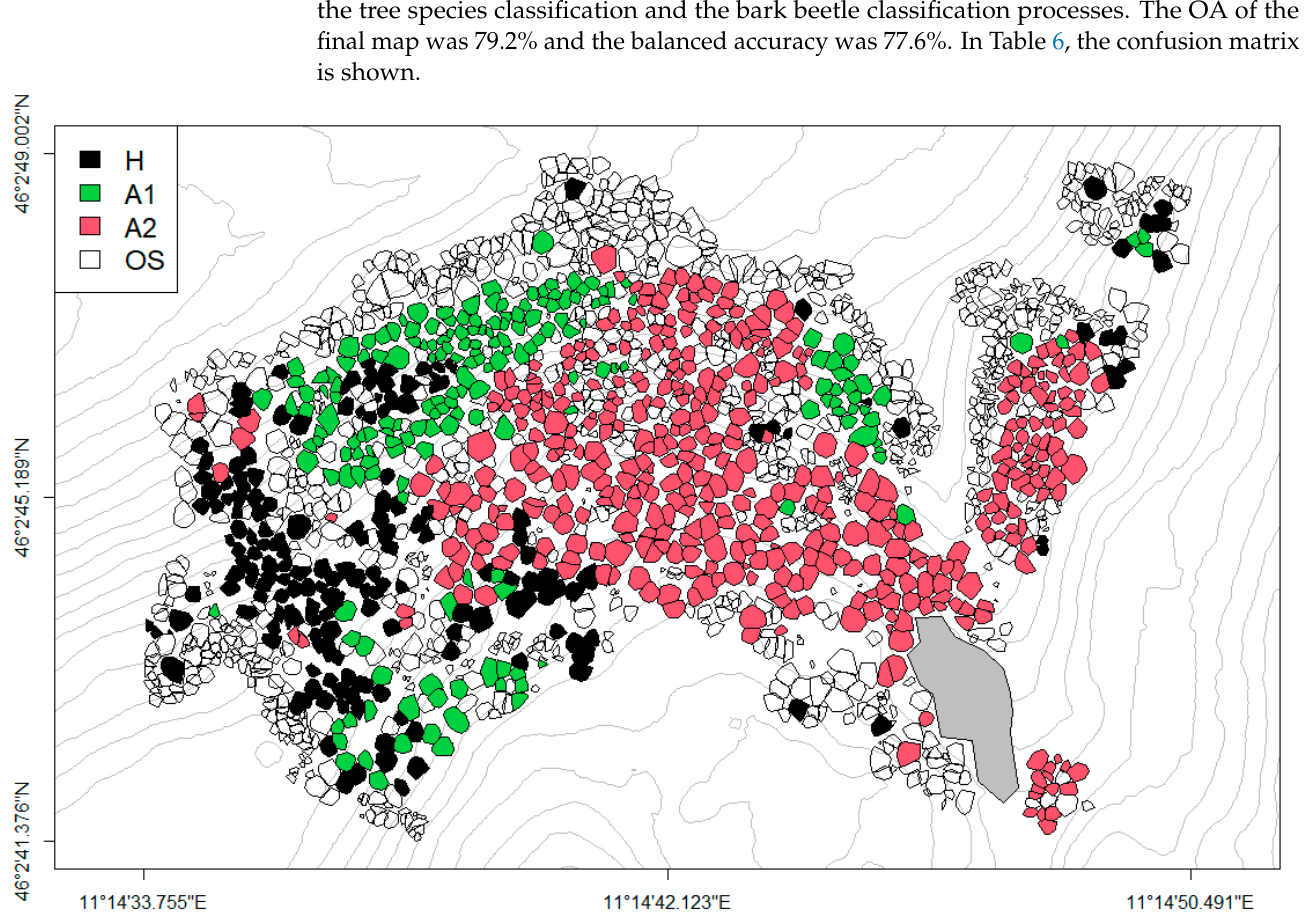
Figure 4. Classification map at ITC level for the S2 image of the 30 September 2020 obtained with the wSVM classifier. The grey area on the bottom-right part is an area where a windthrow event happened. The lines are the altitude contour lines, spaced by 5 m.